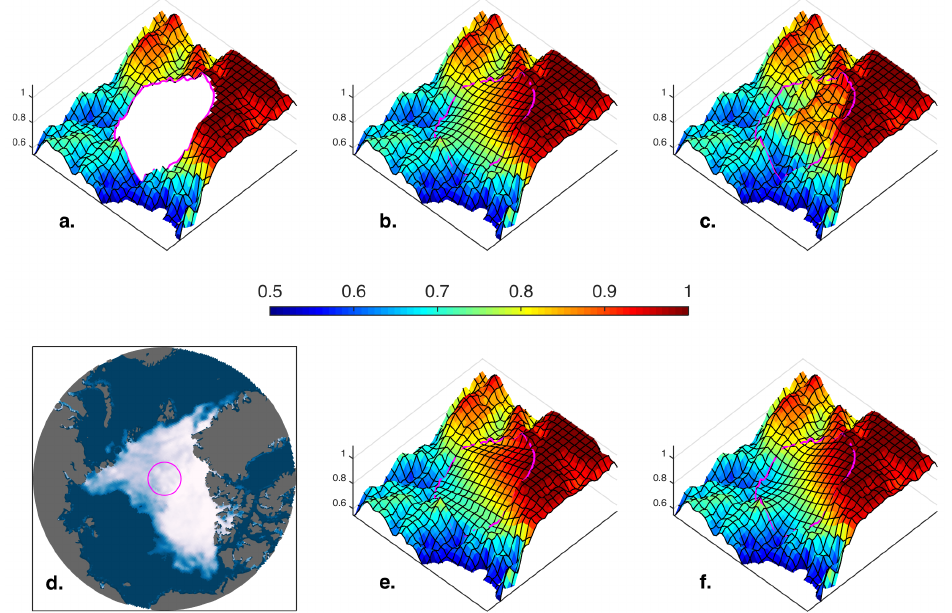
Figure 4. A three-dimensional view of the 30 August 2007 example from Figure 3d–f. Shading and surface elevation indicate concentration, and black curves are provided to help visualize the three dimensionality of the surface. ( a ) Observed sea ice concentrations around the polar data gap; ( b ) polar data gap replaced by solution to Laplace’s equation ψ ( x , y ) ; ( c ) polar data gap replaced by ψ plus the stochastic term Ω ; ( d ) same as Figure 3f but rotated to illustrate the geographic orientation of the other panels; ( e ) polar data gap replaced by bilinear interpolation; and ( f ) polar data gap replaced by thin plate